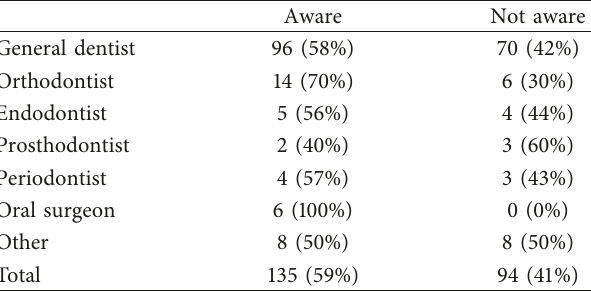
Table 4: Dentists’ interest on the benefits of collaborations with physical therapists to treat TMD patients by dentist